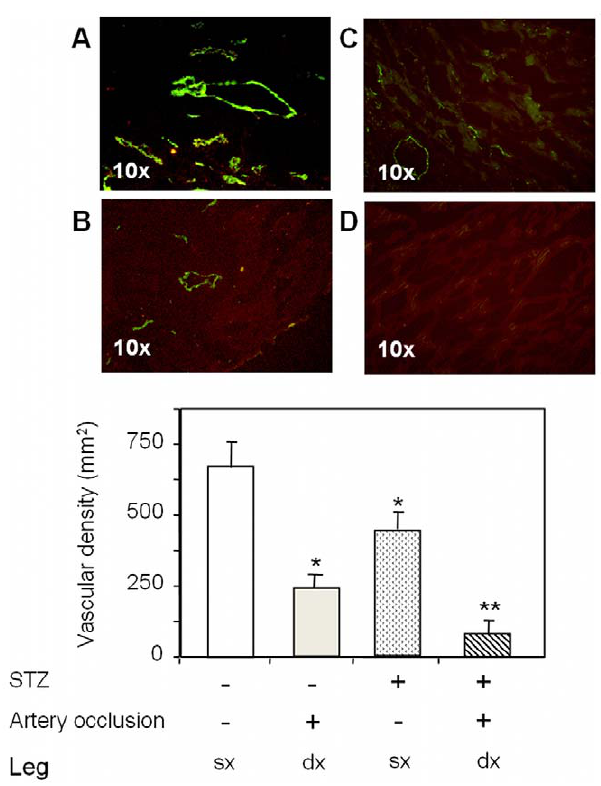
Figure 7. Immunofluorescence analysis. Panels A, B: Represen- tative sections of skeletal muscle tissues of non-diabetic rats, taken from non-occluded limbs (panel A), occluded limbs (Panel B), stained with fluorescein-conjugated anti-von Willebrand factor antibody. Panels C, D: Representative sections of skeletal muscle tissues of diabetic rats, taken from non-occluded limbs (panel C) and occluded limbs (panel D) , stained with fluorescein-conjugated anti-von Willebrand factor antibody. Vascular density was significantly lower in limbs with femoral artery ligation and diabetes. Legend: STZ, streptozotocin-treated rats. Values are mean 6 SD. N=6 for non-diabetic group, N=7 for diabetic group.